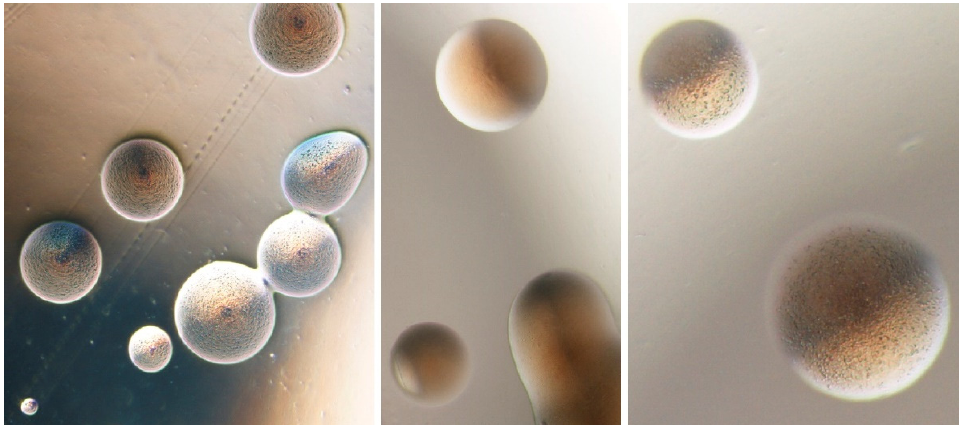
Figure 2. Phytoplasma colonies in solid medium CB [31] taken using optical microscope at 40× magnification (courtesy N.